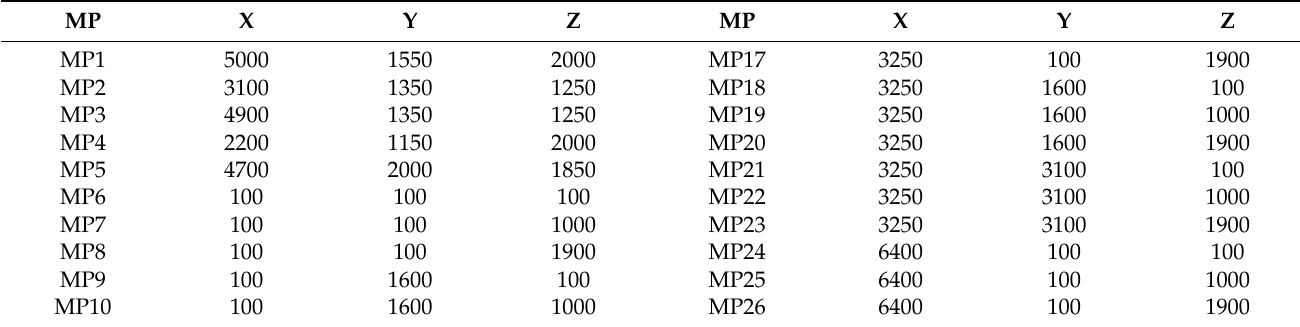
Table 6. Coordinates of the gas monitoring points.